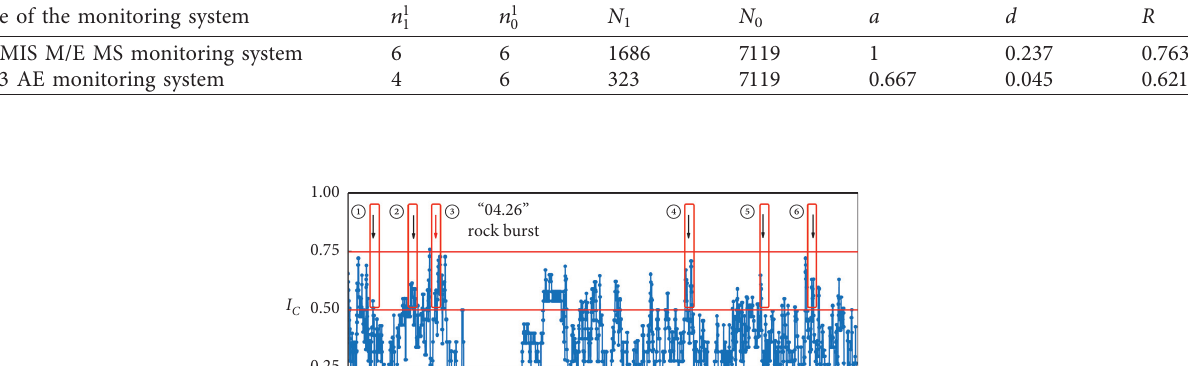
Table 5: Early warning capability of different monitoring systems.